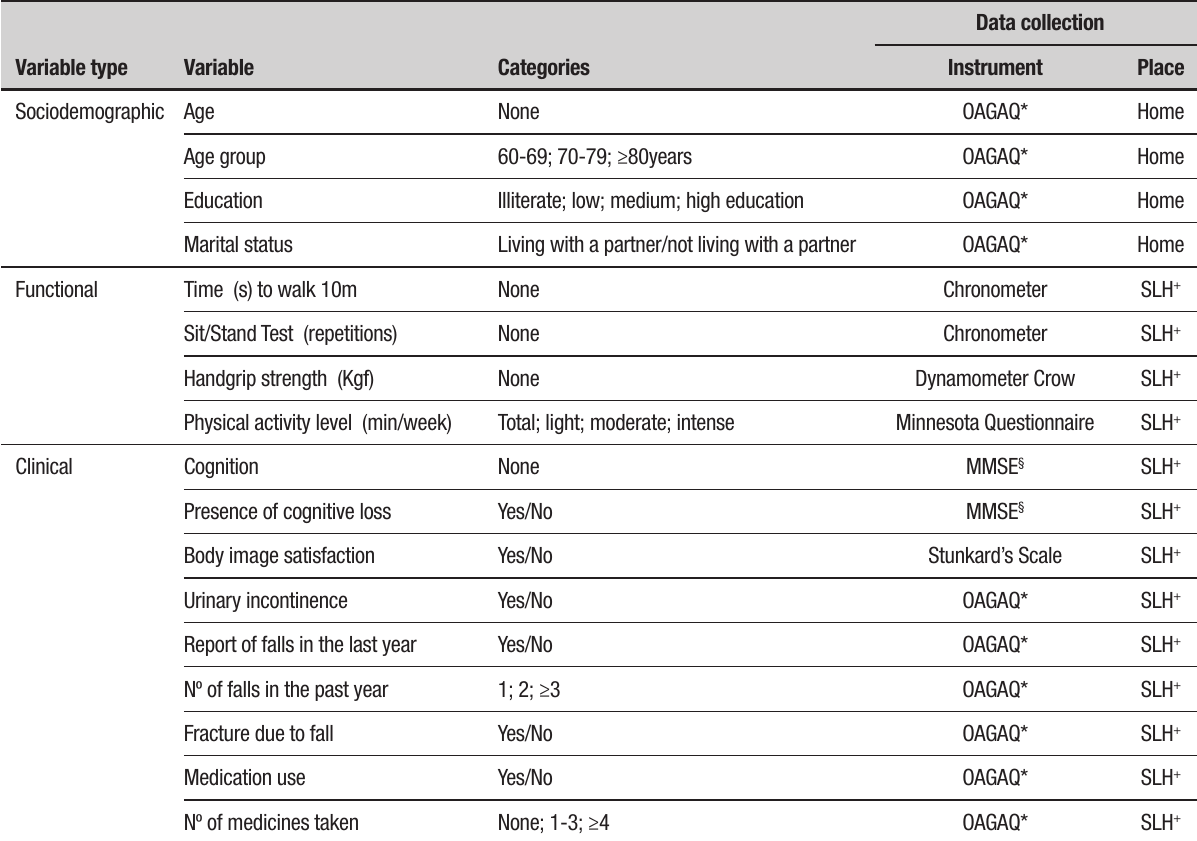
Table 1. Description of study variables, instruments used and place of data